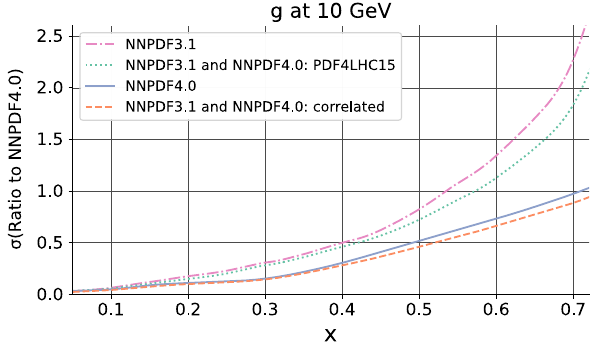
Fig. 9 Comparison of the relative uncertainty on the large x gluon PDF determined using (from top to bottom) NNPDF3.1 methodol- ogy (purple, dot-dashed), NNPDF3.1 and NNPDF4.0 uncorrelated (PDF4LHC15) combination (green, dotted), NNPDF4.0 methodology (blue, solid), correlated combination (orange,